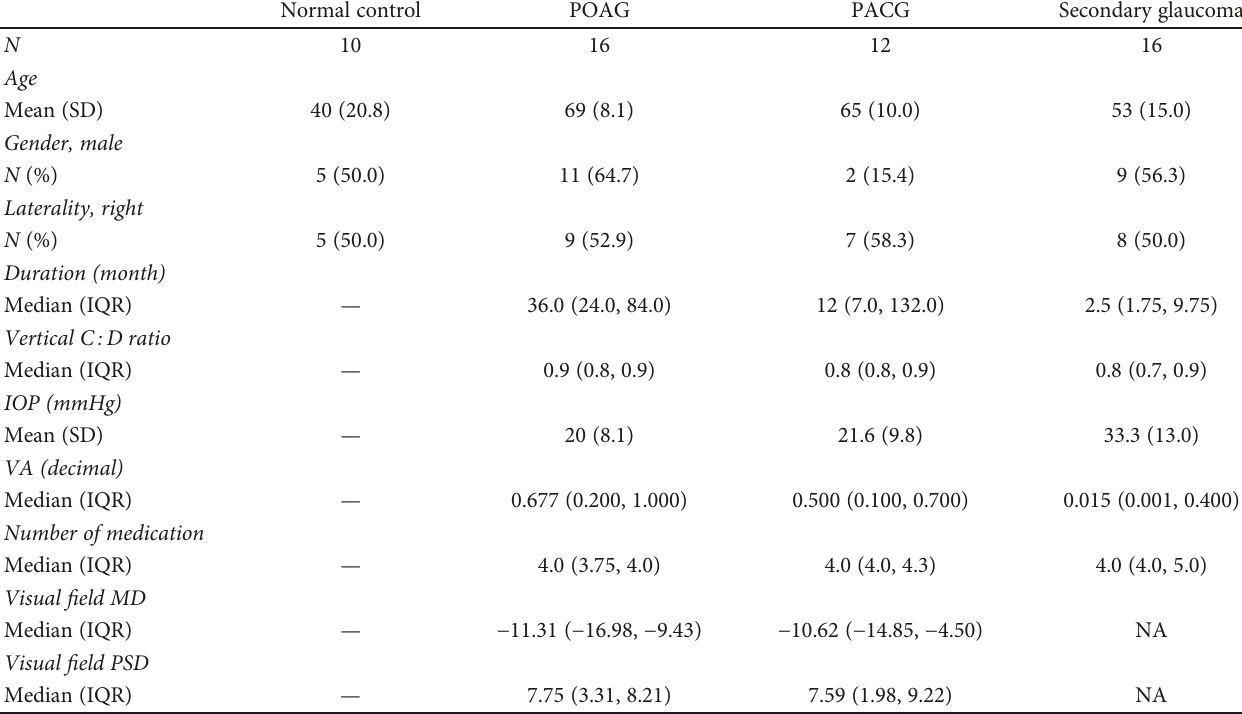
Table 1: Demographic and clinical characteristics of the subjects.